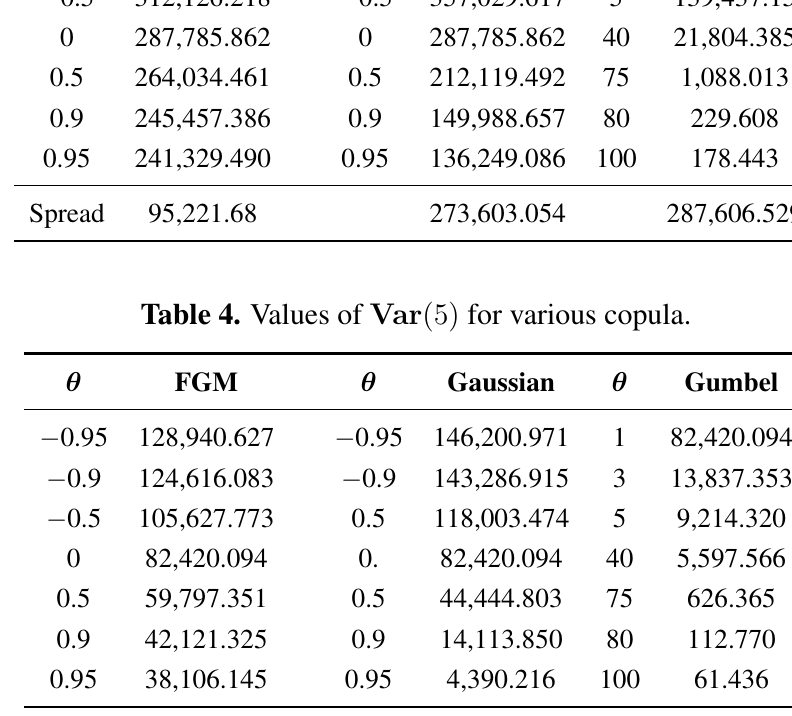
Table 3. Values of µ (2)